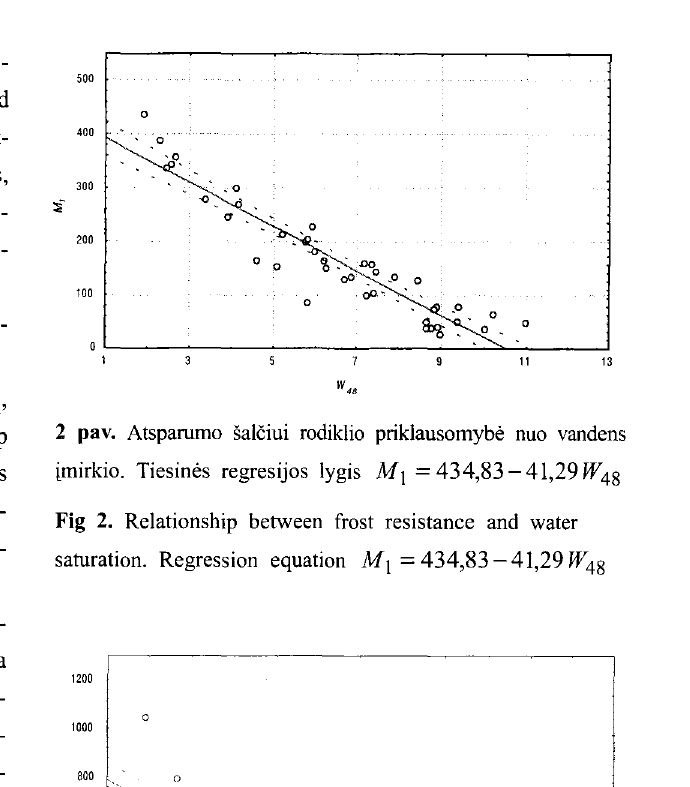
3 pav. Atsparumo salciui rodiklio priklausomybe nuo vandens tmirkio. Tiesines regresijos lygis M 2 = 872,52- 83,59 W4s Fig 3. Relationship between frost resistance and water saturation. Regression equation M